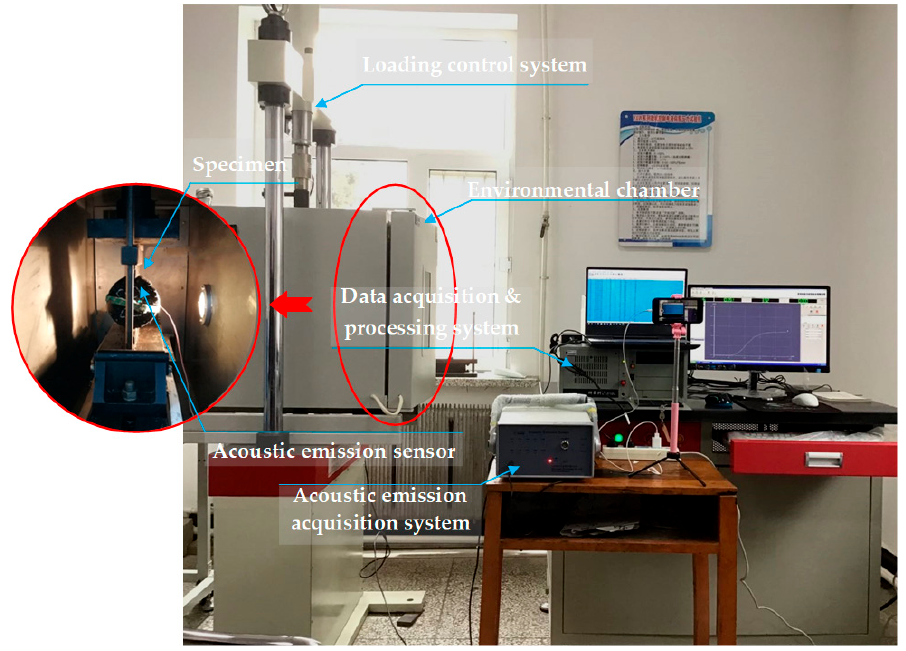
Figure 4. Low-temperature splitting test used in this study.